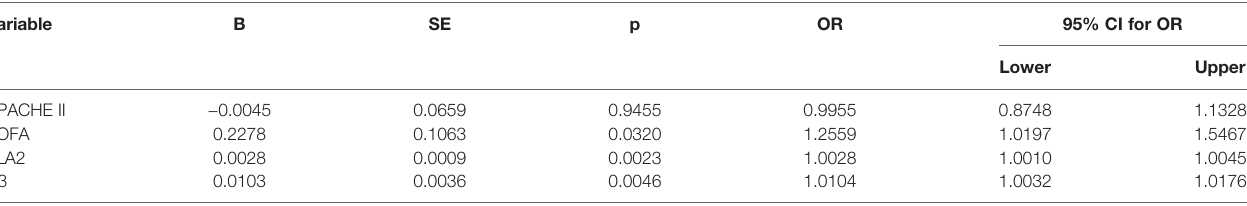
DIC, disseminated intravascular coagulation; APACHE, Acute Physiology and Chronic Health Evaluation; SOFA, Sequential Organ Failure Assessment; ELA2, neutrophil elastase 2; H3, citrullinated histone